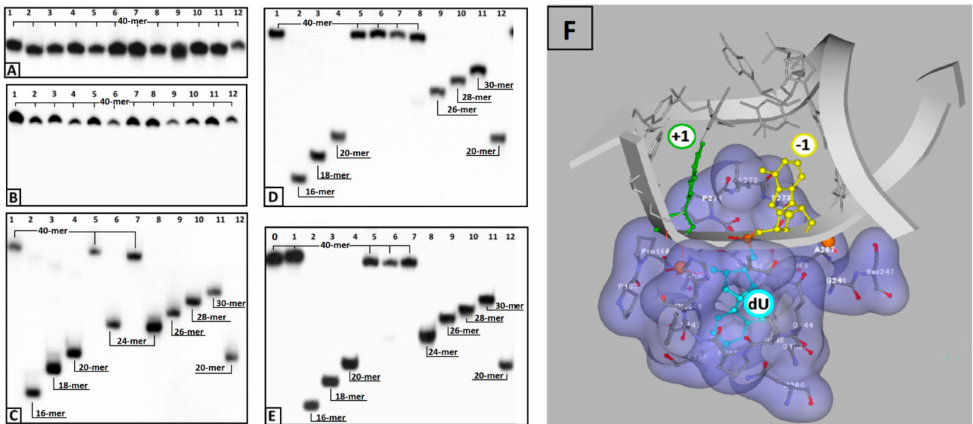
Figure 2. Autoradiograms of denaturing PAGE: ( A ) the purity of ss -oligonucleotides; ( B ) ss -DNA digested by UDG and hAPE1; ( C ) ss -DNA digested by UDG and hAPE1 with subsequent 1M piperidine treatment; ( D ) ds -DNA digested by UDG and hAPE1; ( E ) ds -DNA digested by UDG and hAPE1 with subsequent 1M piperidine treatment (undigested ss -Native oligonucleotide as Line 0). Lines: 1) Native, 2) S cdA(-7), 3) S cdA(-5), 4) S cdA(-3), 5) S cdA(-1), 6) S cdA ( + 1), 7) R cdA(-1), 8) R cdA( + 1), 8) S cdA( + 3), 10) S cdA ( + 5), 11) S cdA( + 7), 12) Cont.dU(0); ( F ) graphical representation of cdA spatial distribution